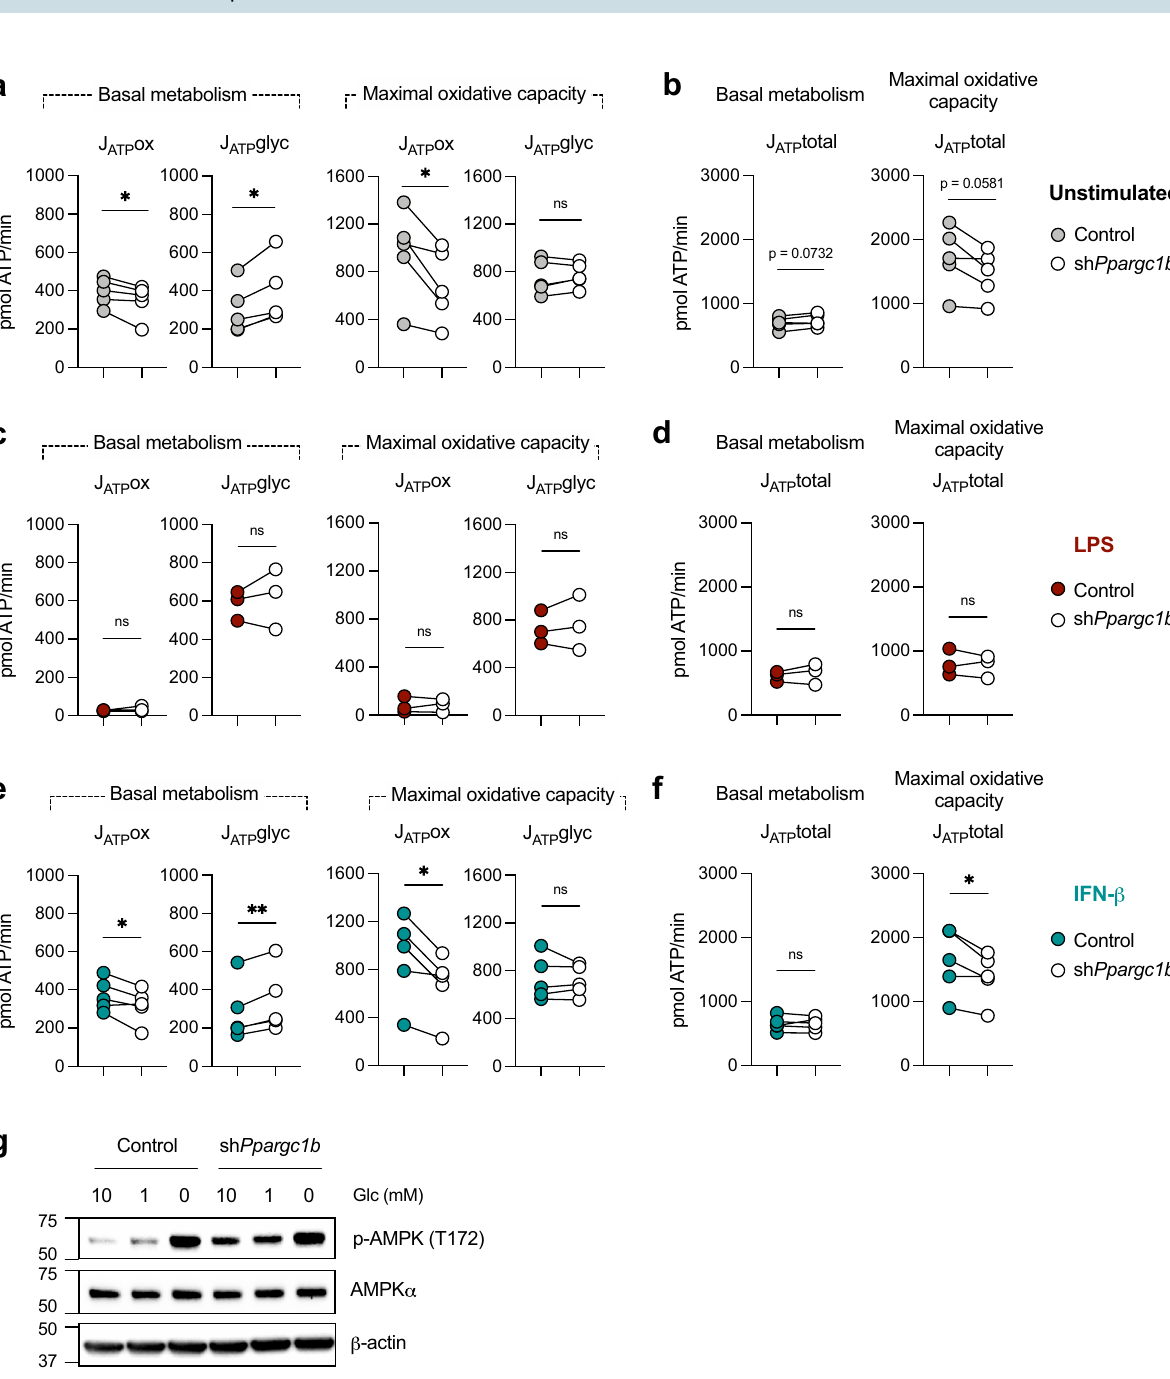
Figure 3. Effect of PGC-1β on metabolic phenotype of differentially-activated DCs.DCs were transduced with control shRNA or Ppargc1b shRNA and ( a ) ATP production rates by oxidative metabolism (J ATP ox) and glycolysis (J ATP glyc) were calculated from Seahorse assay measurements (see Methods) at basal (left) and maximal (right) respiratory rates. ( b ) Total ATP production rates (J ATP total) at basal metabolism and maximal respiration were determined by adding J ATP ox and J ATP glyc from ( a ). ATP production rates by oxidative metabolism (J ATP ox) and glycolysis (J ATP glyc) were calculated from Seahorse assay measurements in DCs stimulated with ( c , d ) LPS (100 ng/mL) or ( e , f ) IFN-β (1000 U/mL). Total ATP production rates of stimulated DCs in ( d , f ) at basal metabolism and maximal respiration were determined by adding J ATP ox and J ATP glyc from ( c , e ). Colored circles are control DCs and open circles are DCs transduced with Ppargc1b shRNA. ( g ) AMPK phosphorylated at threonine 172 (p-AMPK T172), AMPKα, and β-actin, were visualized by western blot for DCs that were cultured in media containing 10, 1, or 0 mM glucose. Data are of ( c , d ) three or ( a , b , e , f ) five experiments pooled together, with each individual experiment represented by a circle and values from the same experiment joined by a line. Data in ( g ) are of one experiment representative of three experiments. Statistical significance was determined by paired t -test. *p < 0.05, **p <